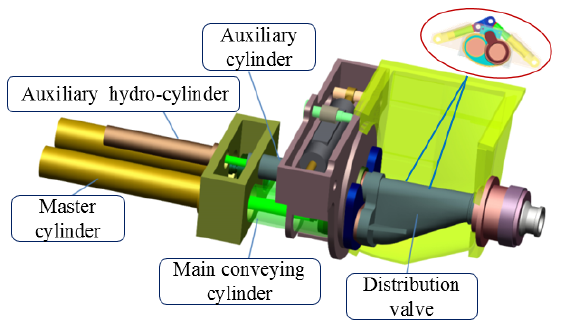
Figure 15. Non-pulse wet spraying machine-three cylinder structure [79].